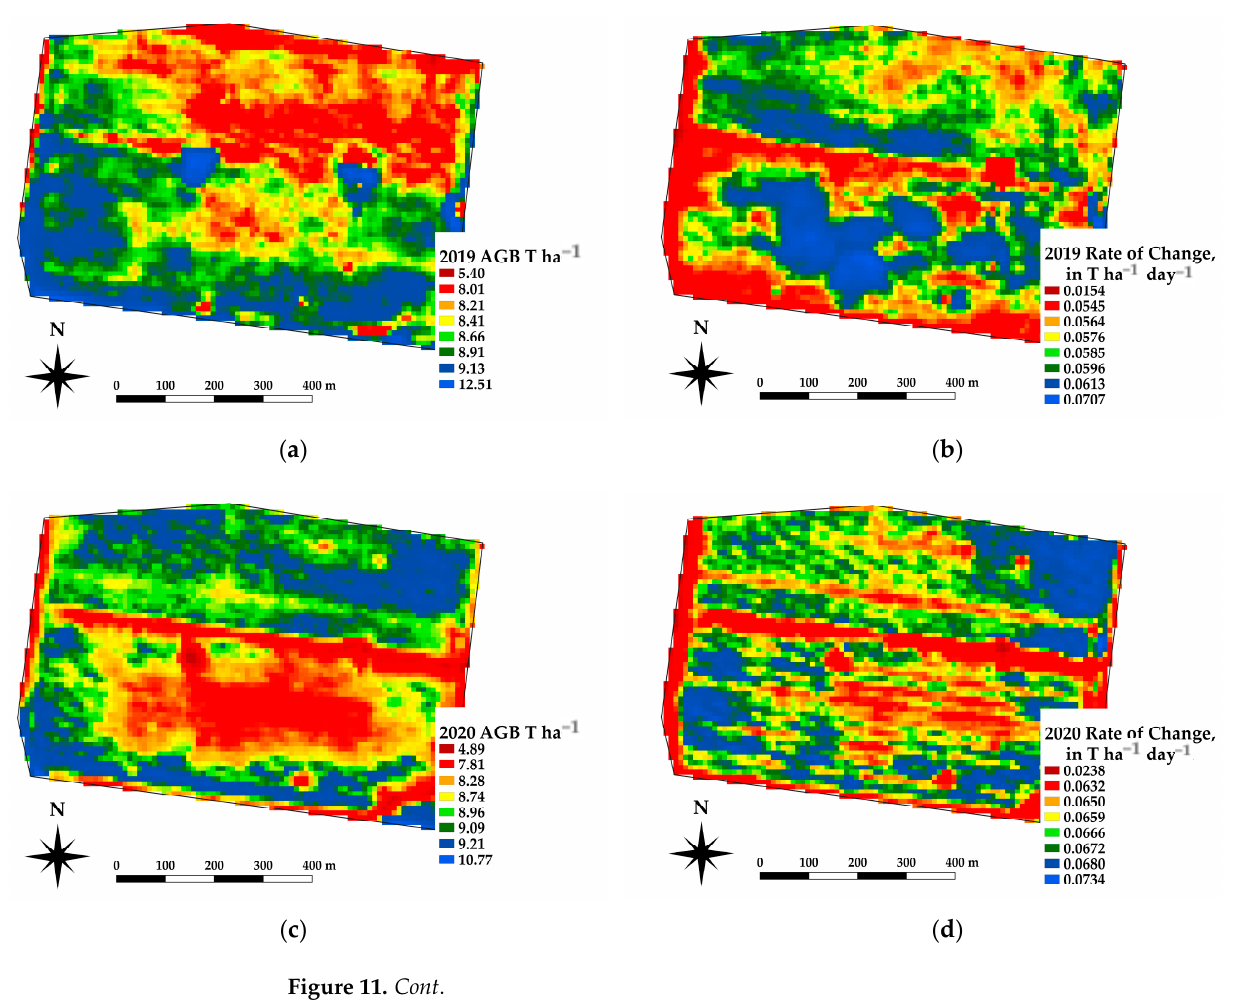
( f ) Figure 11. Example estimates of AGB and Rate of Change for the same paddock sown to different crops. ( a , b ) AGB and ROC for canola at DOY 300, 2019. ( c , d ) AGB and ROC for wheat at DOY 300, 2020. ( e , f ) AGB and ROC for faba beans at DOY 300, 2021. 5. Conclusions The framework presented offers the ability to estimate the spatial estimates of the AGB at daily time steps and spatial resolutions well suited to characterise in-field biomass